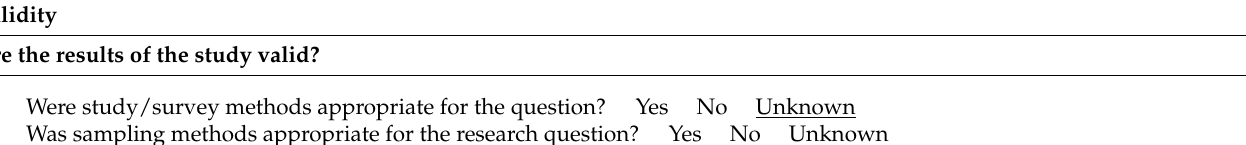
Table A8. Rapid Critical Appraisal Questions for descriptive studies—Neirmeyer (1999) study. Citation: Niermeyer, S.